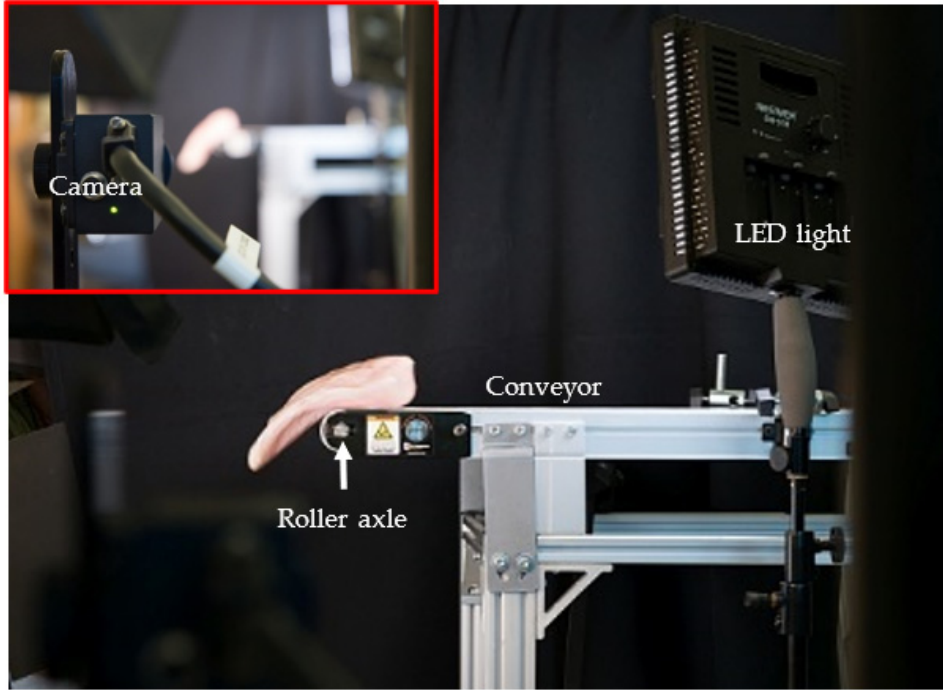
Figure 2. Picture of the developed imaging system with a fillet falling off the conveyor.